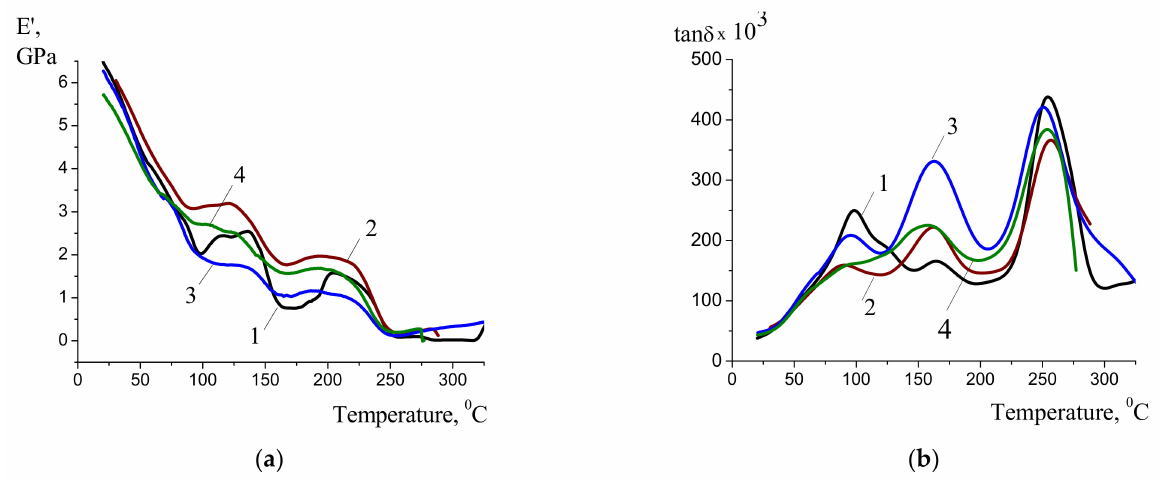
Figure 1. Temperature dependences of storage modulus E’ ( a ) and tan δ ( b ) for pure chitosan film (1) and chitosan-based composite films containing 10% (2), 20% (3), and 30% (4) of